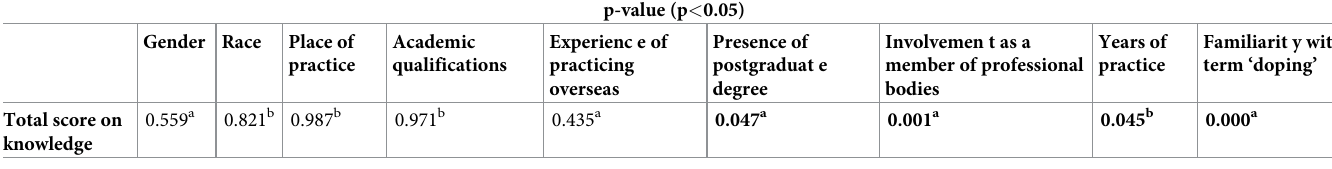
Table 4. Association between demographic variables and the respondents’ knowledge